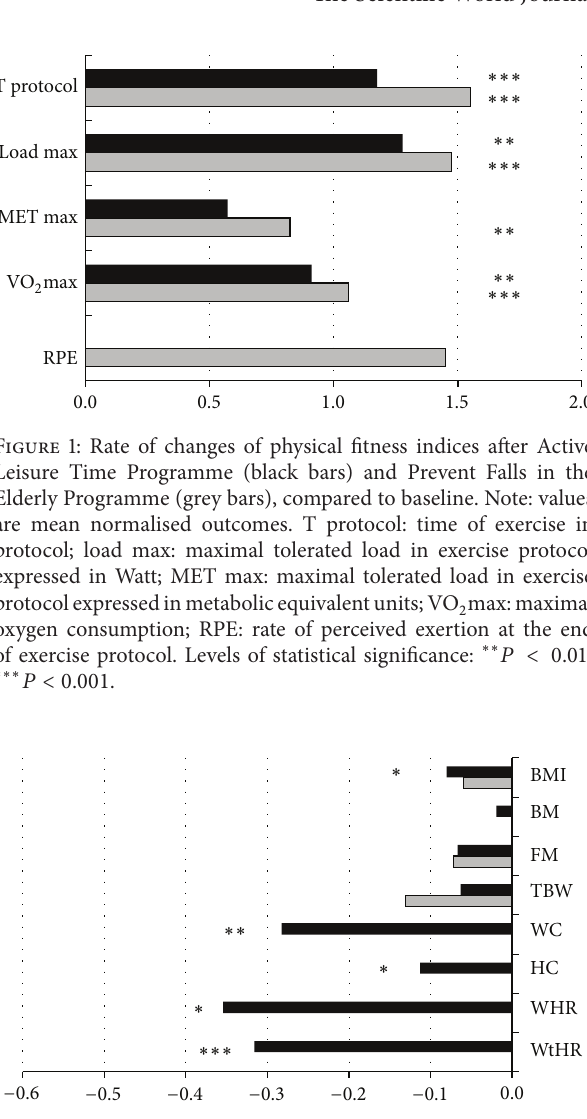
Figure 2: Rate of changes of somatic variables after Active Leisure Time Programme (black bars) and Prevent Falls in the Elderly Programme (grey bars), compared to baseline outcomes. Note: values are mean normalised outcomes. BMI: body mass index; BM: body mass; FM: fat mass; TBW: total body water; WC: waist circumference; HC: hips circumference; WHR: waist to hip ratio; WtHR: waist to height ratio. Levels of statistical significance: ∗ 𝑃 <